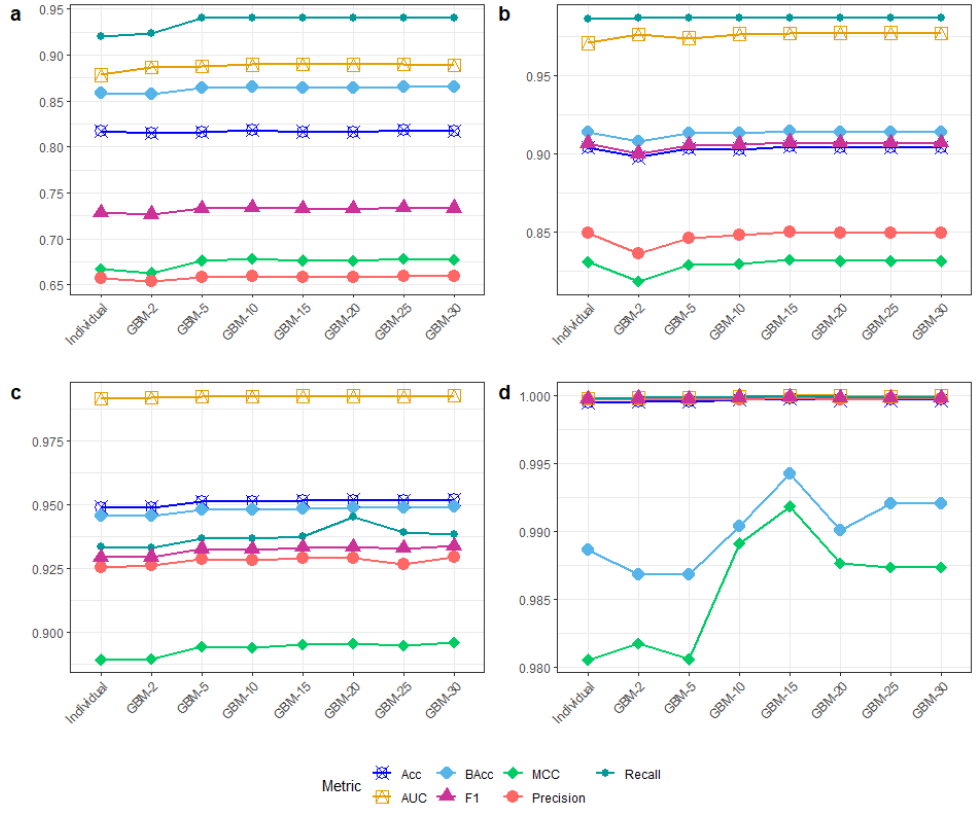
Figure 2. Performance average of all classification algorithms on KDDTest-21 ( a ), KDDTest+ ( b ), UNSW-NB15-Test ( c ), and CICIDS-2017 ( d